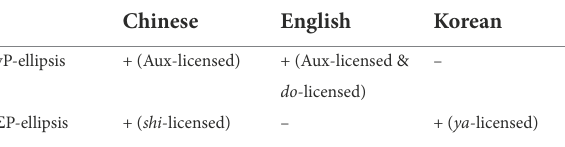
TABLE 1 Summary of the availability of vP-ellipsis and Σ P-ellipsis in Chinese, English and